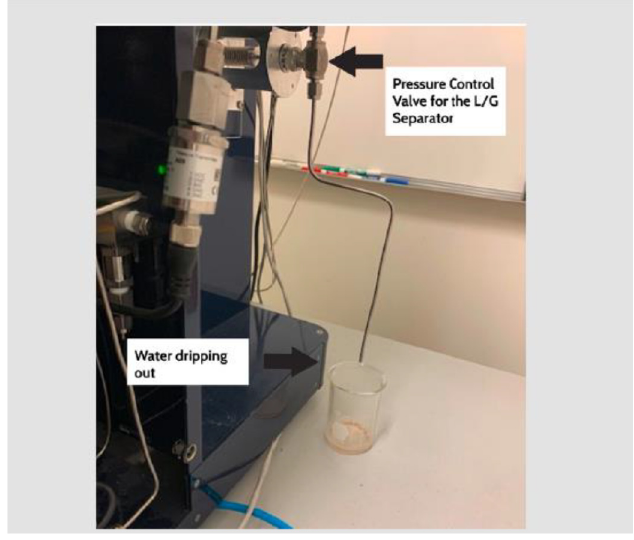
Figure 4. Water dripping out from the L/G separator.